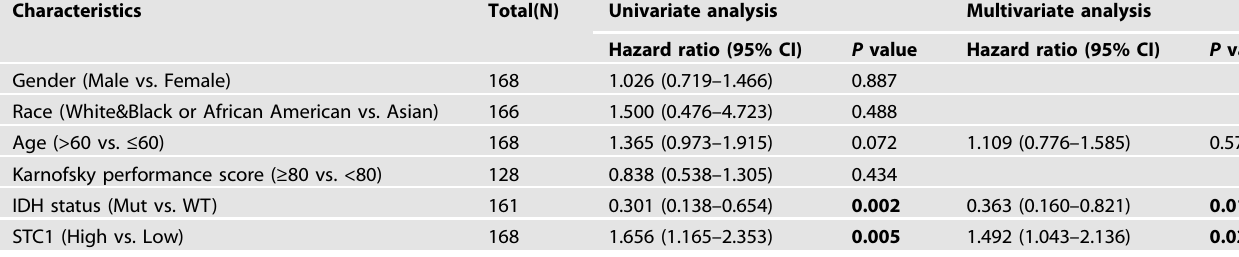
Table 2. Univariate and multivariate analyses of various prognostic parameters in patients from the TCGA GBM cohort. Characteristics